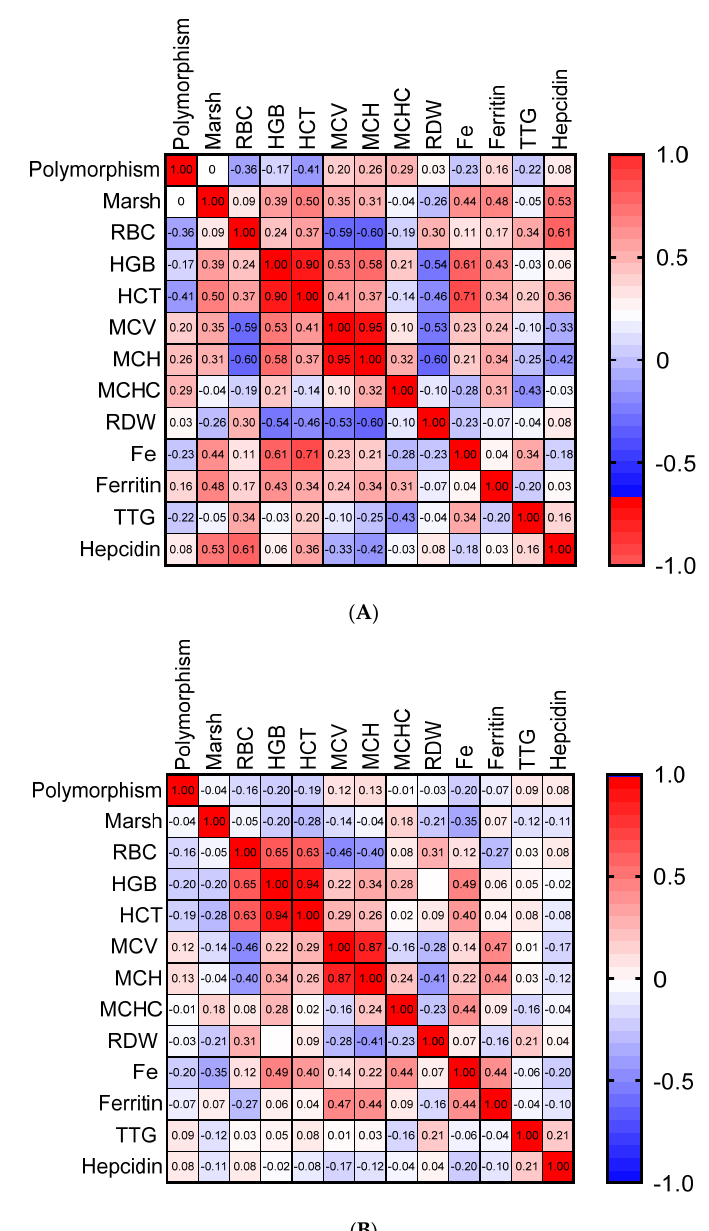
Figure 3. Heatmap representation of the correlations between anemia-related parameters after 12 months of GFD in children with ( A ) and without ( B ) initial anemia. Marsh—Marsh classification; RBC—red blood cells; HGB—hemoglobin; HCT—hematocrit; MCV—mean corpuscular volume; MCH—mean corpuscular hemoglobin; MCHC—mean corpuscular hemoglobin concentration; RDW—red cell distribution width; Fe—iron; TTG—auto-antibodies directed against tissue transglutaminase 2.